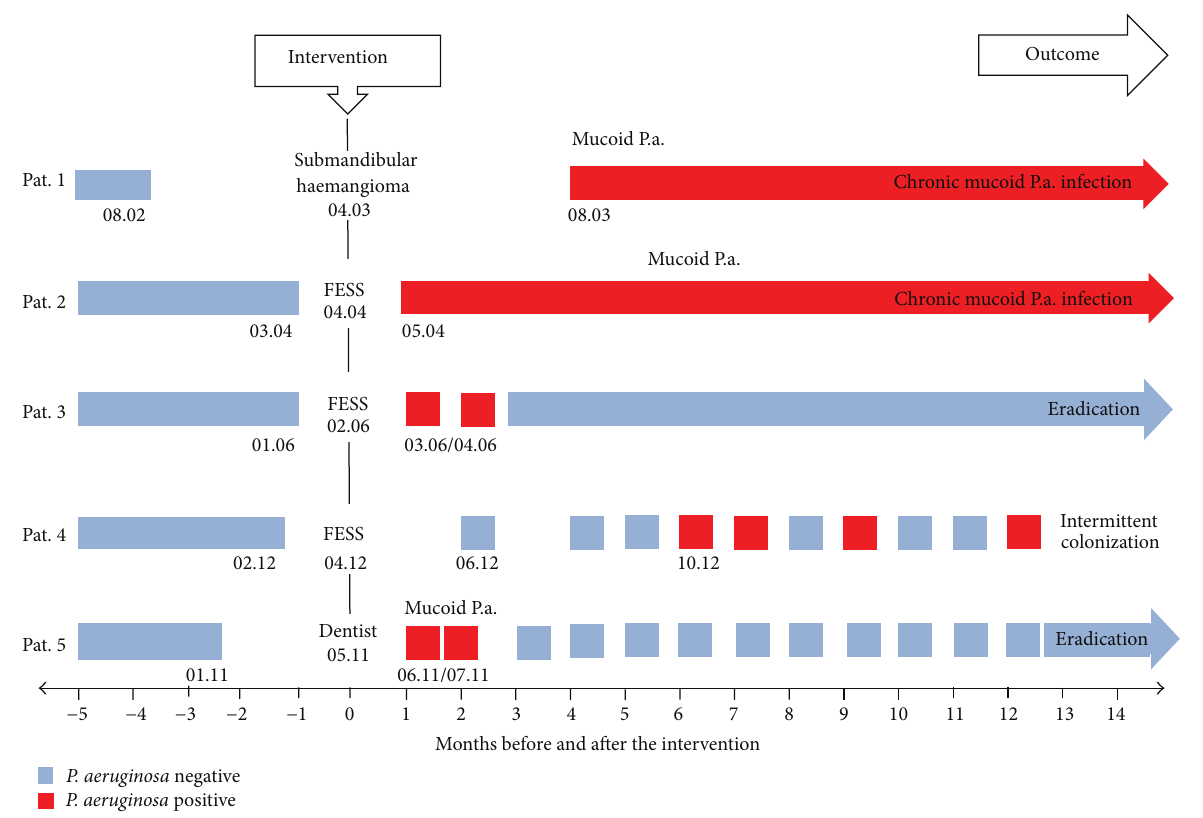
Figure 1: Different courses and outcomes after P. aeruginosa (P.a.) colonization in context of ORL-surgery or dentist treatment. Pat.: patient; FESS: functional endoscopic sinus surgery.